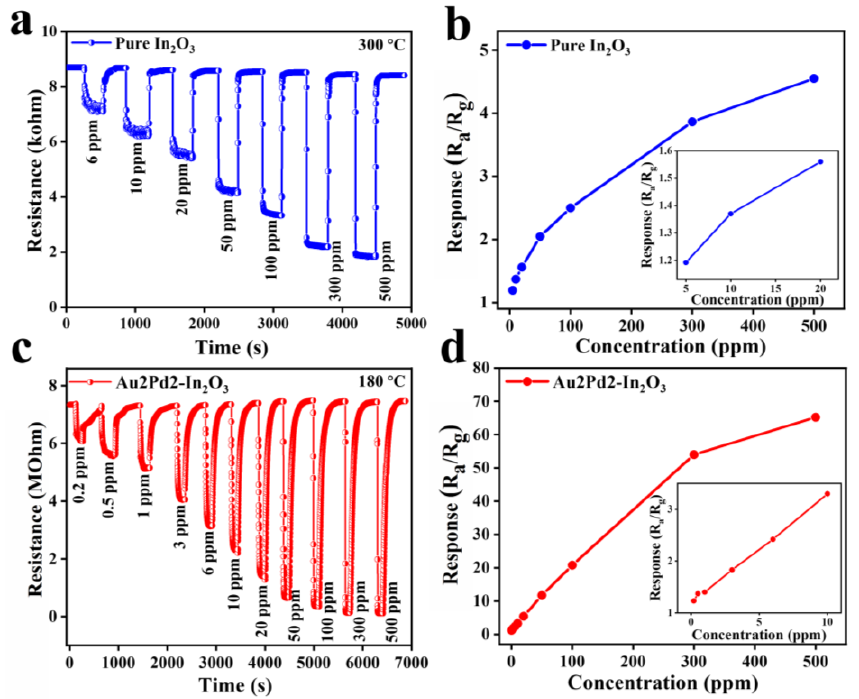
Figure 7. The sensor dynamic response curves of ( a ) pure In 2 O 3 and ( c ) Au2Pd2-In 2 O 3 samples; the corresponding response values of ( b ) pure In 2 O 3 and ( d ) Au2Pd2-In 2 O 3 samples at different concentrations of CO at 180 °C.